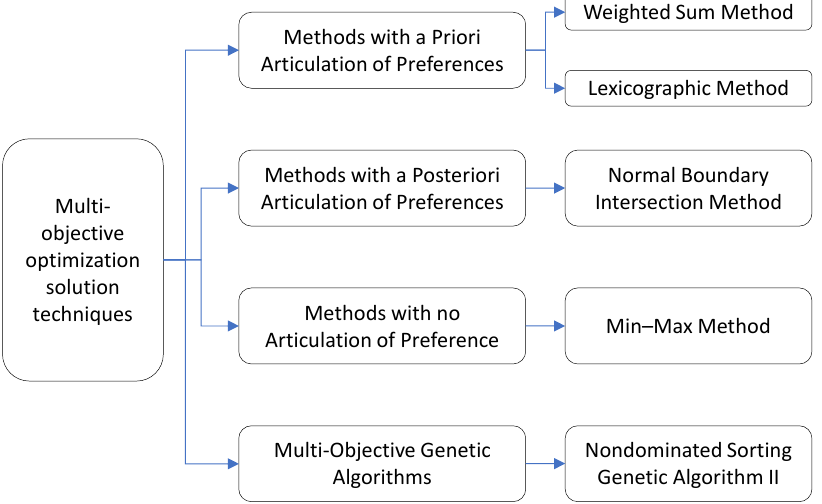
Figure 2. Categorization of multi-objective optimization techniques.